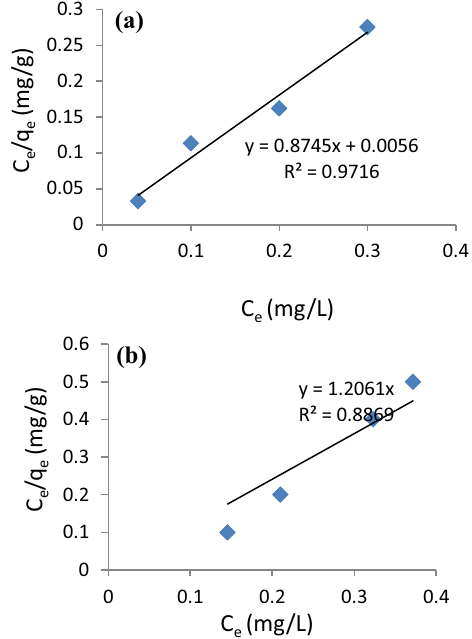
Fig. 1 a Langmuir Isotherm for effect of initial fluoride ion concen- tration on defluoridation (Acid treated Moringa oleifera leaves pow- der). b Langmuir Isotherm for effect of initial fluoride ion concentra- tion on defluoridation (Alkali treated Moringa oleifera leaves